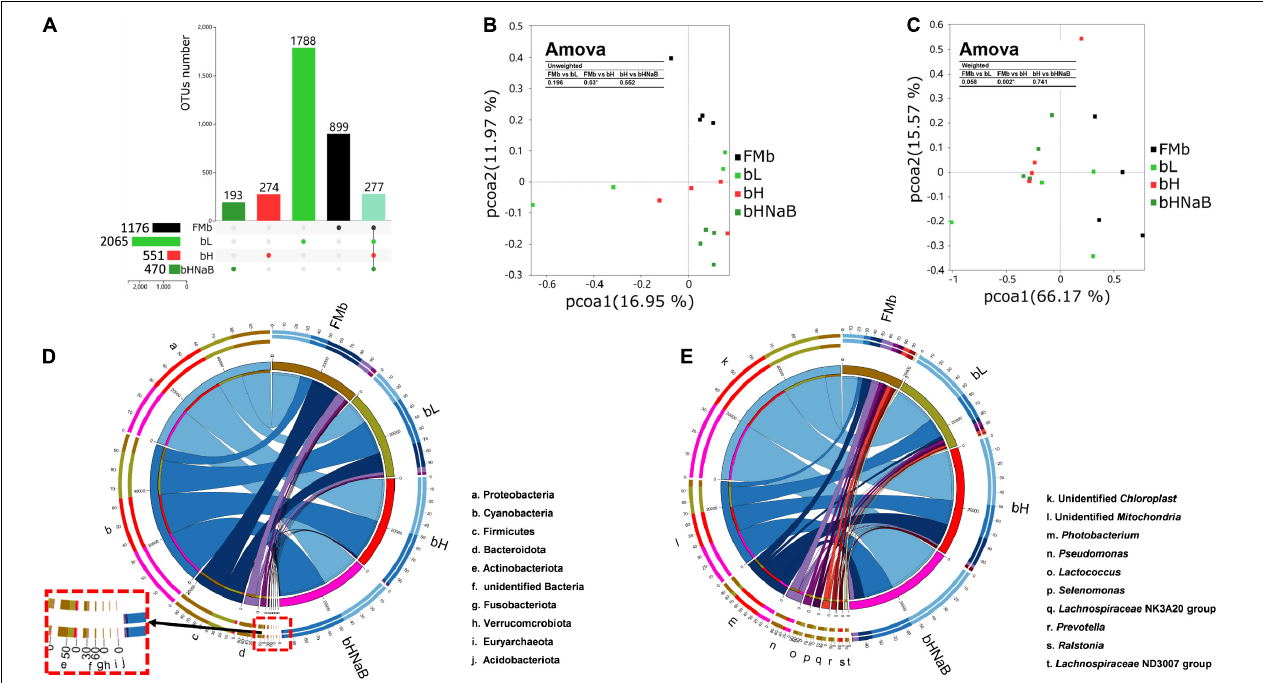
FIGURE 2 | Distal intestinal microbial diversity and composition of hybrid grouper. The numbers of unique and shared OTUs between different treatments indicated by UPSET (A) . The horizontal bars indicate the total OTUs for each treatment, the vertical bars indicate the specific OTUs for each treatment, and the rightmost vertical bar indicates the shared OTUs of all treatments. PCoA plots based on unweighted UniFrac metrics (B) and weighted UniFrac metrics (C) , and Amova analysis was used to determine the significant differences in distance between two groups. Color code, FMb: #000000; bL: #31CB31; bH: #FF3131; bHNaB: #319831; shared OUTs: 91E1BD. Circos graphs of dominant bacterial phyla (top 10) (D) and genera (top 10) (E) in the distal intestinal. The right semicircle represents the phyla and genera composition of each treatment, and the left semicircle indicates the distribution of each phyla and genera in the different treatments.